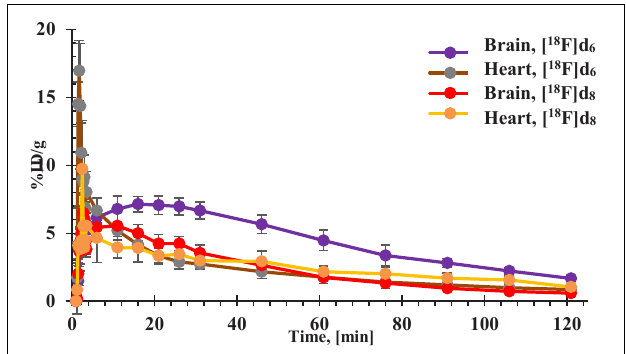
FIGURE 9 | Time-activity curves (TACs) of [ 18 F]d 6 and [ 18 F]d 8 obtained from the brain and heart tissues of healthy C57BL/6J mice.